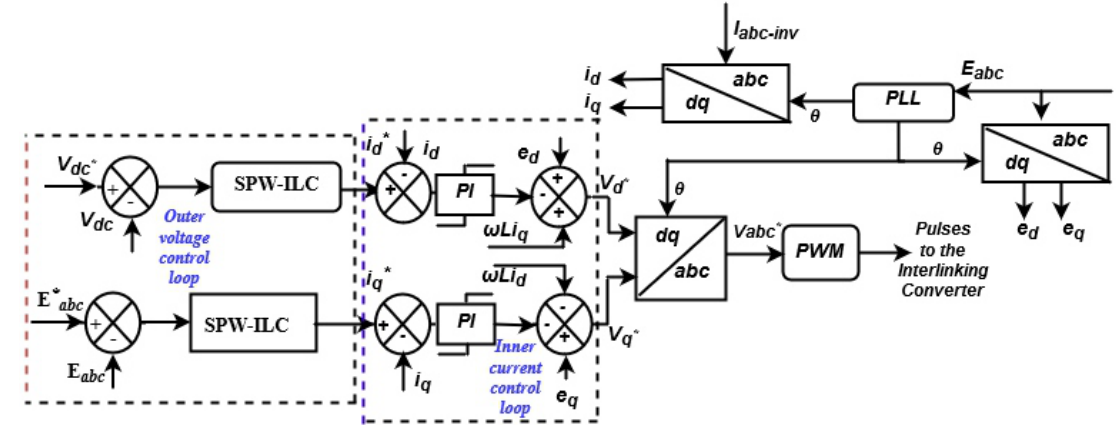
Figure 15. Control circuit for Interlinking converter of Aichi Micro grid